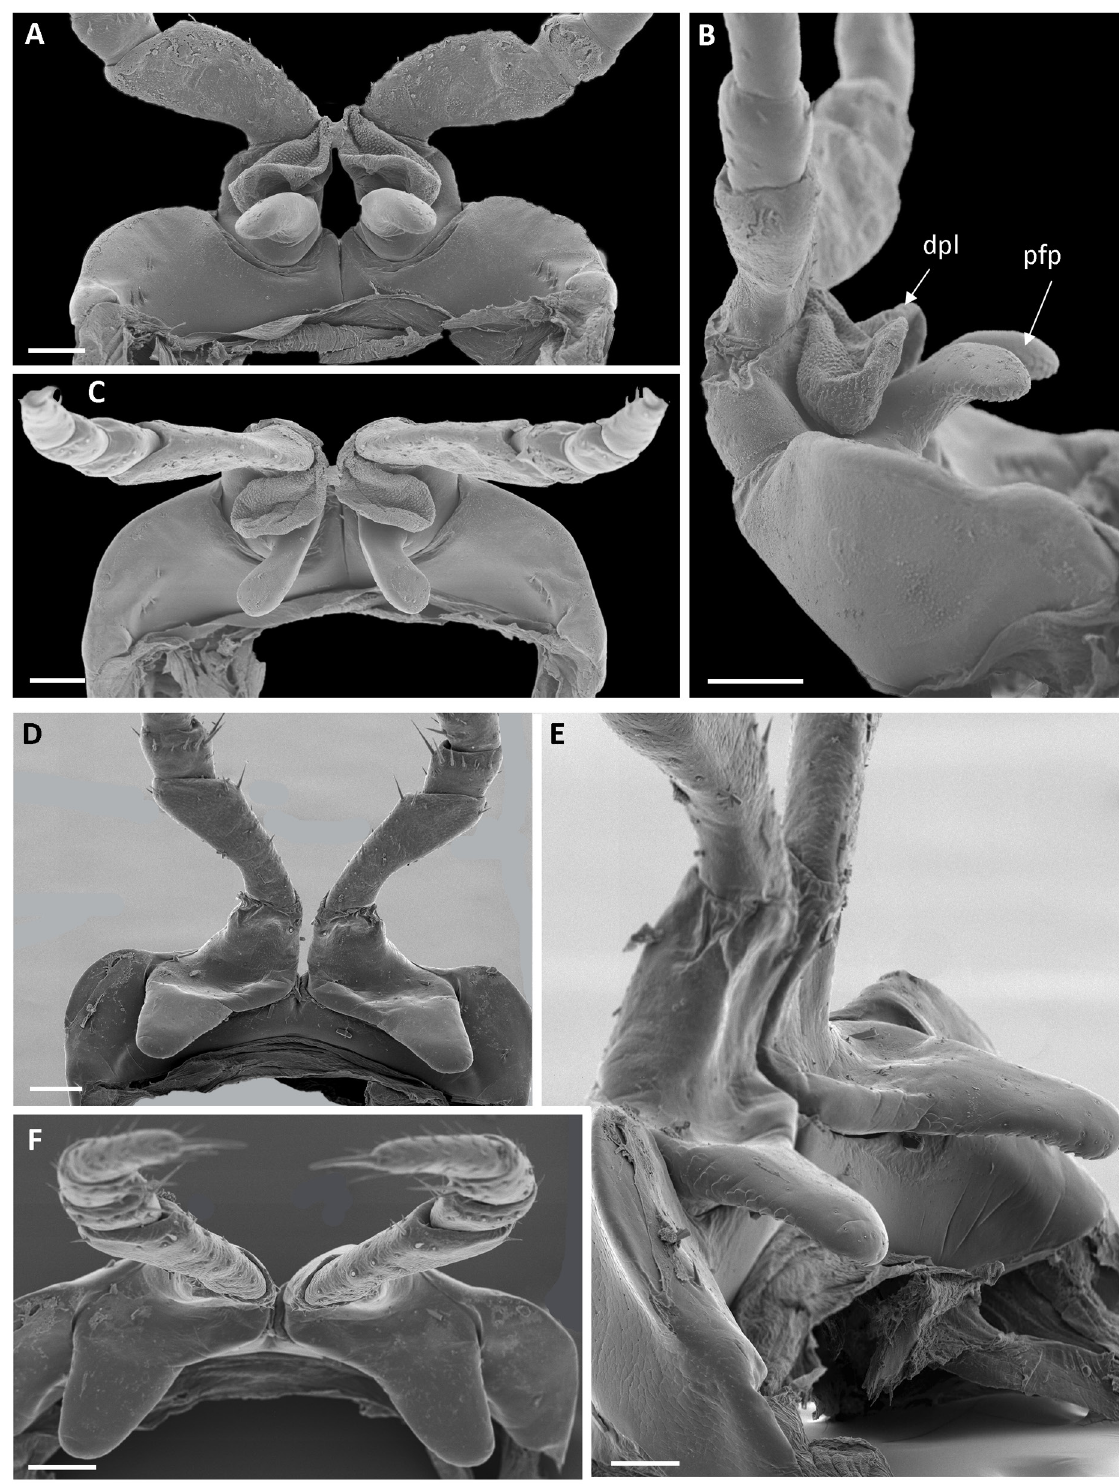
Fig. 6. Aquattuor spp., first pair of male legs. A – C . A. mollilobus sp. nov., paratype, ♂ (NHMD 621647). D – F . A. stereosathe Enghoff, 2015, paratype, ♂ (NHMD 621650). A, D . Anterior view. B, E . (Sub)- lateral view. C, F . (Sub)-ventral view. Abbreviations: dpl = distal prefemoral lobe; pfp = prefemoral process. Scale bars = 0.1